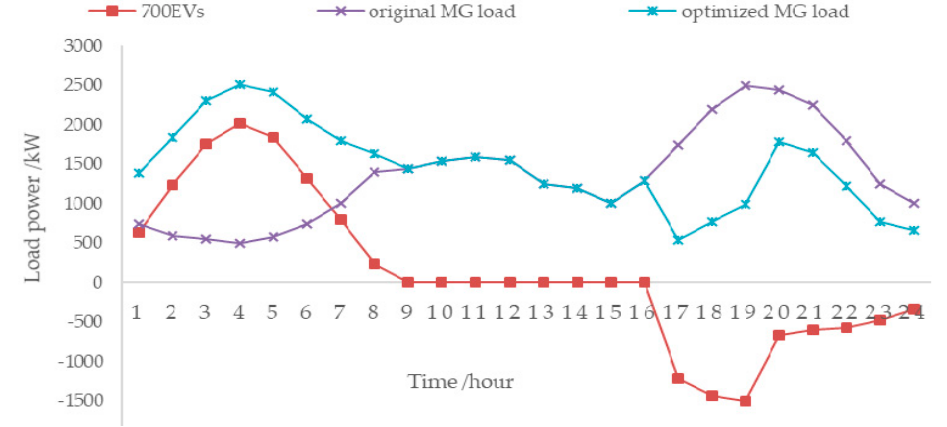
Figure 7. The optimized afterload curve.